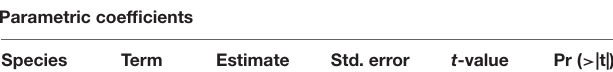
TABLE 3 | Parameters for the GAM models explaining the relationship between Voronoi polygon area and tree basal area (BA), fitted separately for P. abies and B. pubescens.